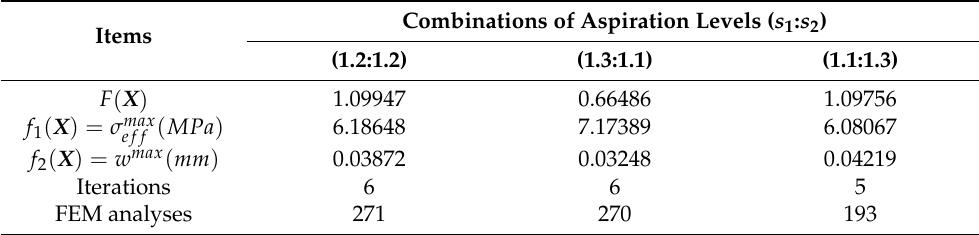
Table 7. The optimization results for three different combinations of aspiration levels.